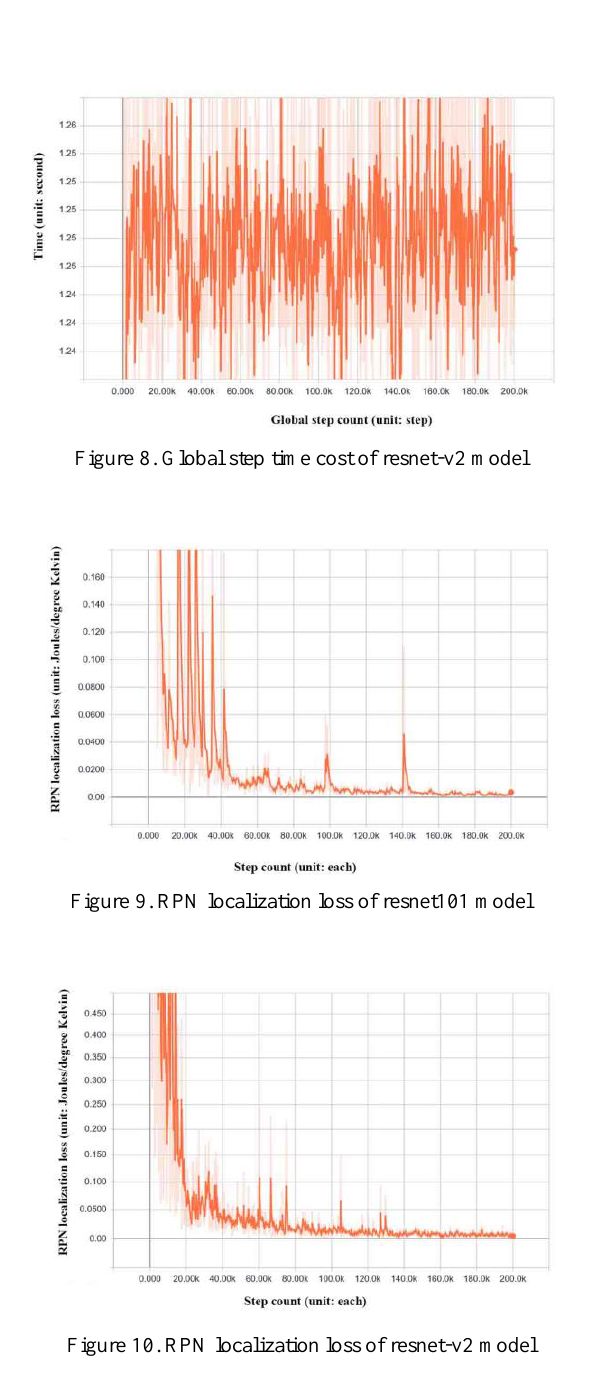
Figure 10. RPN localization loss of resnet-v2 model